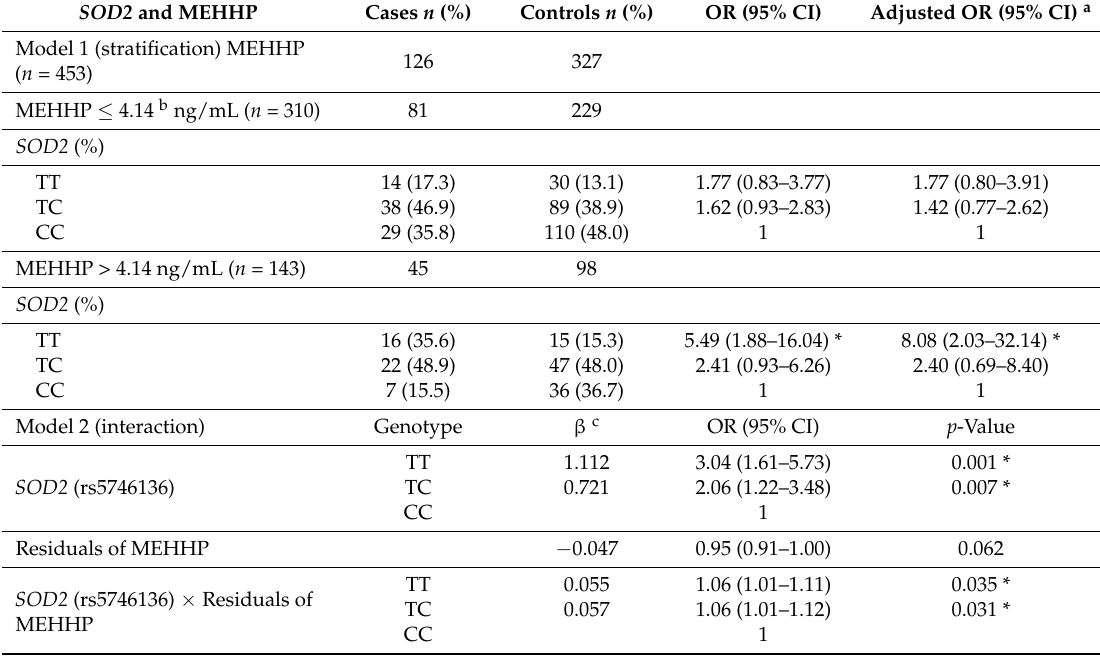
Table 5. Additive interaction of SOD2 genotypes identified by stratification by MEHHP (median and limit of detection level) and multiplicative interaction effect of the SOD2 gene and MEHHP residuals on